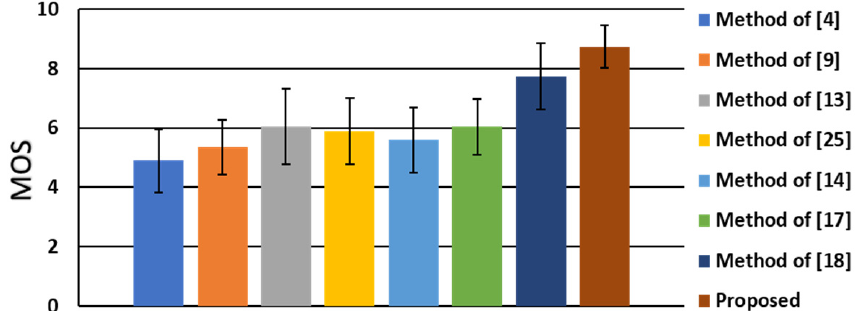
Figure 12. Mean and standard deviation of subjective rankings of the eight comparative algorithms.